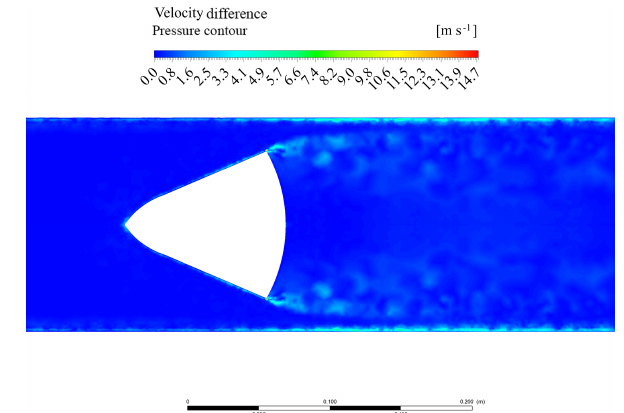
Figure 12. Contour plot of the axial velocity difference between the original mesh and the refined one, proposed cone.